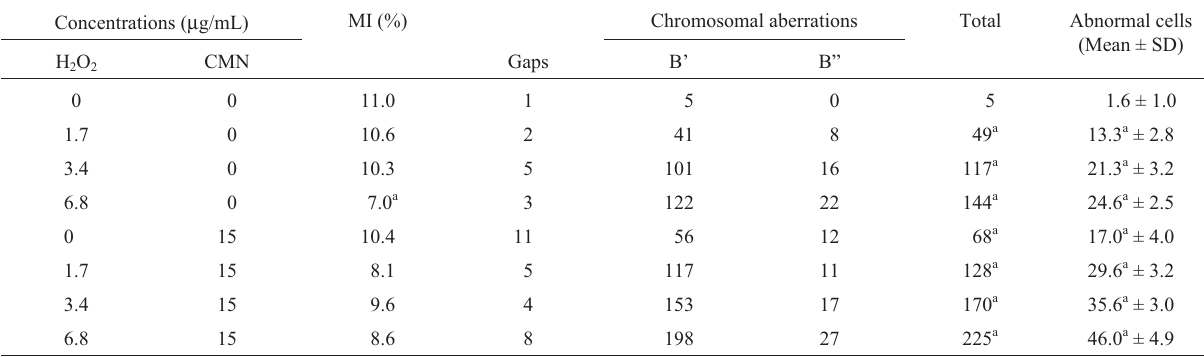
Concentrations ( µ g/mL) MI